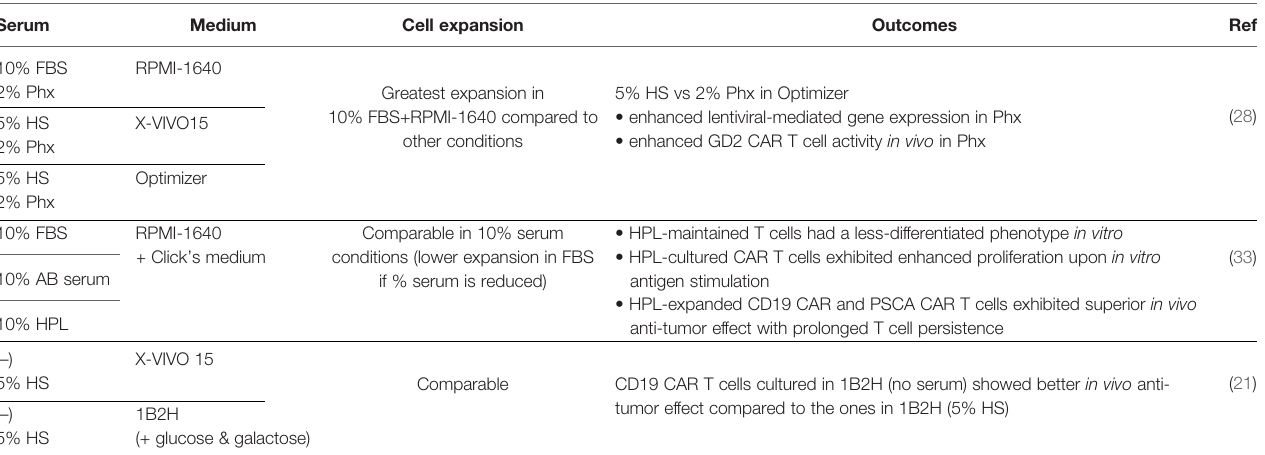
TABLE 2 | Impact of sera on CAR T cell